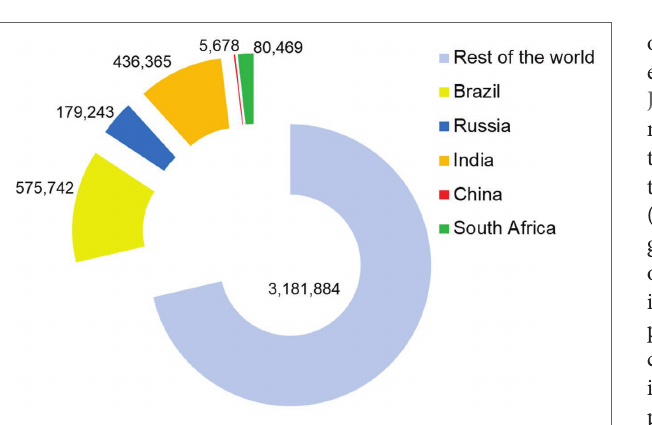
FIGURE 2 | The number of deaths due to COVID-19 in BRICS nations and the rest of the